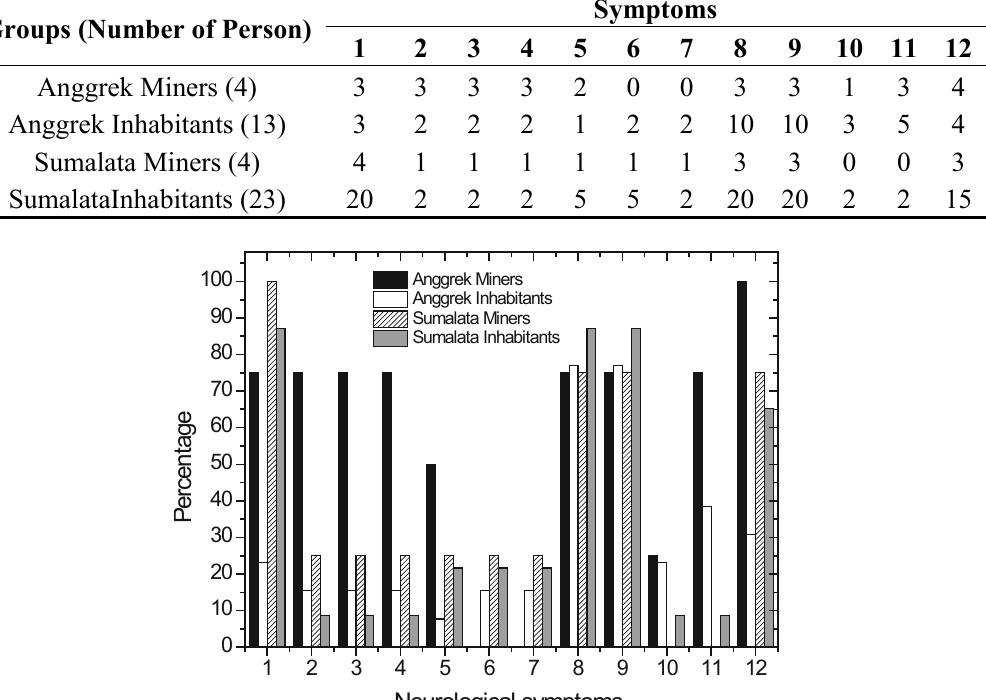
Figure8. Percentage of positive symptoms observed in ASGM miners and inhabitants of Sumalata and Anggrek. Babinski reflex(8)and labial reflex(9) are common symptoms observed in all